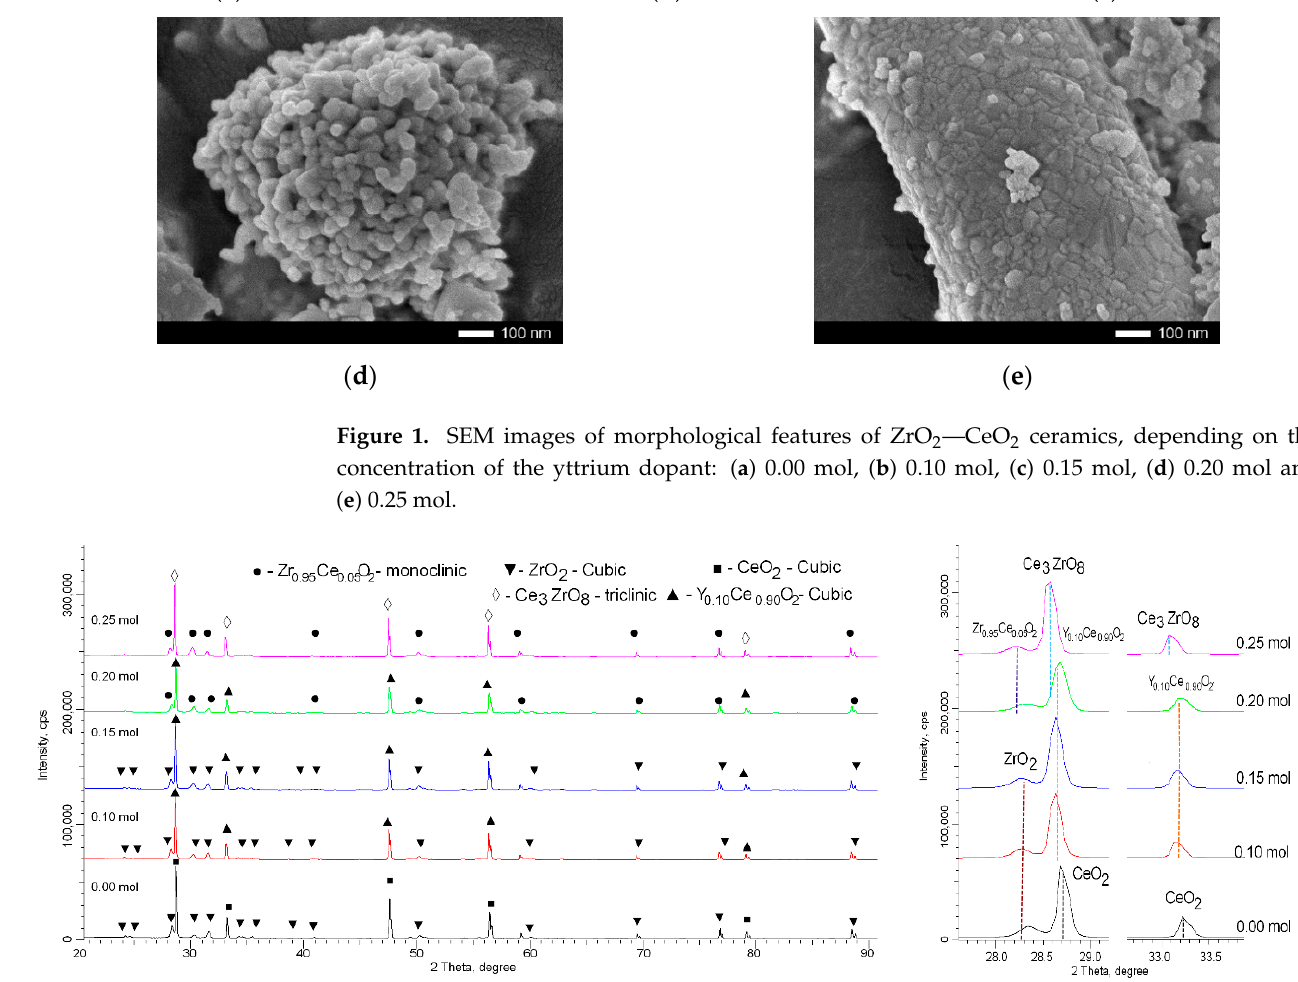
Figure 1. SEM images of morphological features of ZrO 2 —CeO 2 ceramics, depending on the con- centration of the yttrium dopant: ( a ) 0.00 mol, ( b ) 0.10 mol, ( c ) 0.15 mol, ( d ) 0.20 mol and ( e ) 0.25 mol.